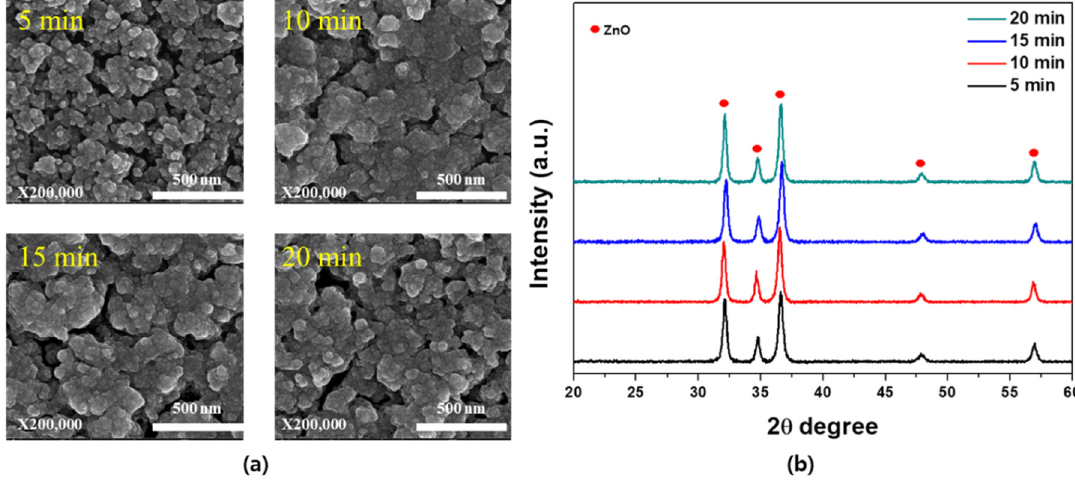
Figure 7. ( a ) Surface SEM images and ( b ) XRD patterns of the formed ZnO films upon variation in the oxidation time.